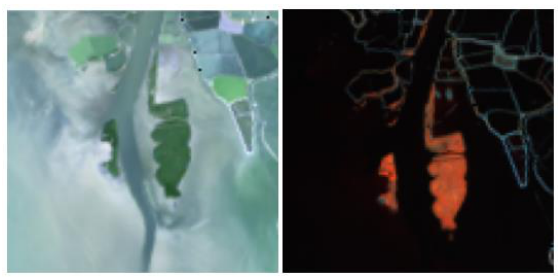
Figure 1 . Band Combination Comparison. True Color (R-G-B), (left), False Color (NIR-SWIR1-SWIR2) (right).